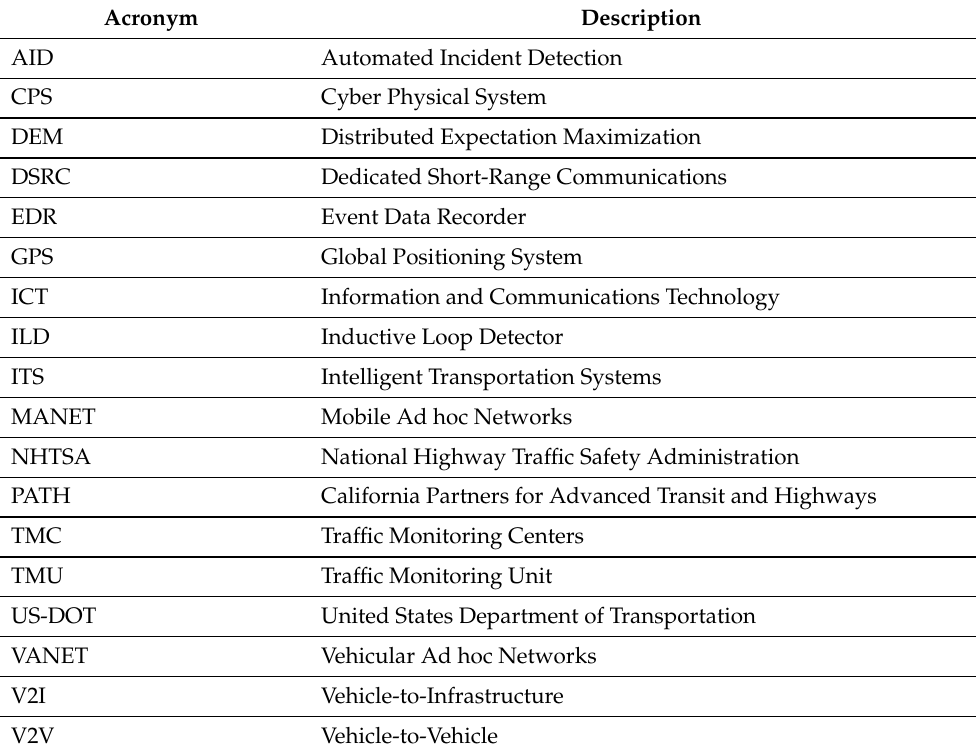
Table 1. A guide to the acronyms used in the